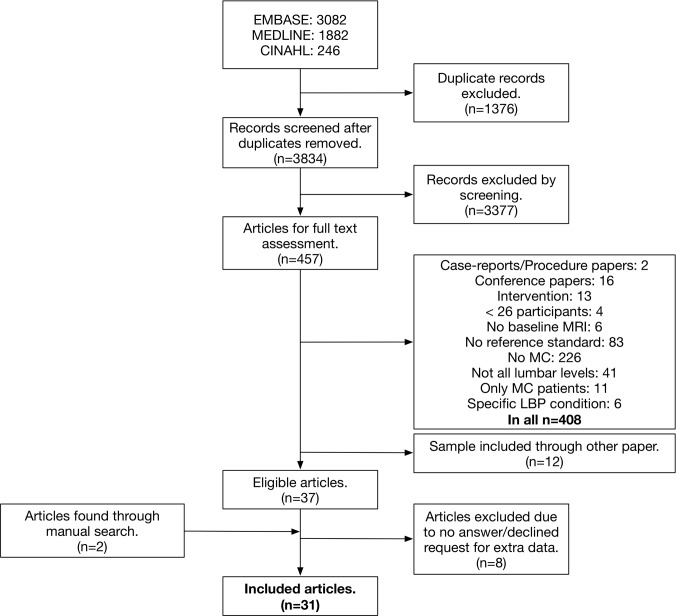
Flow diagram of study selection.